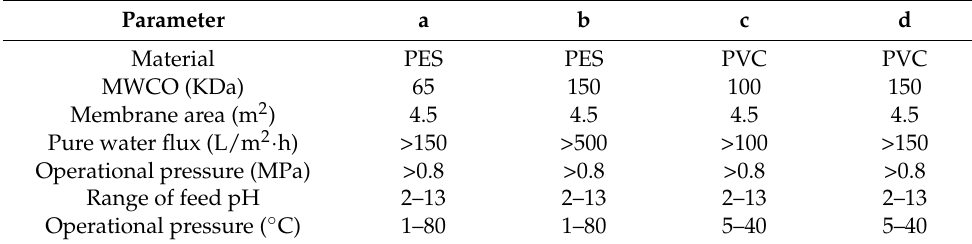
Table 1. Properties of the UF membranes.